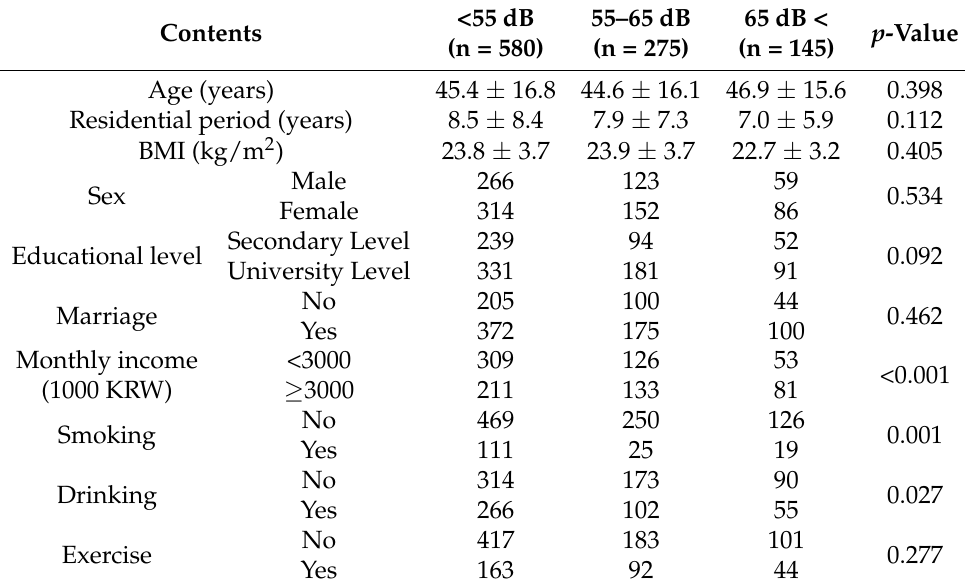
Table 2. Social Demographical data of survey